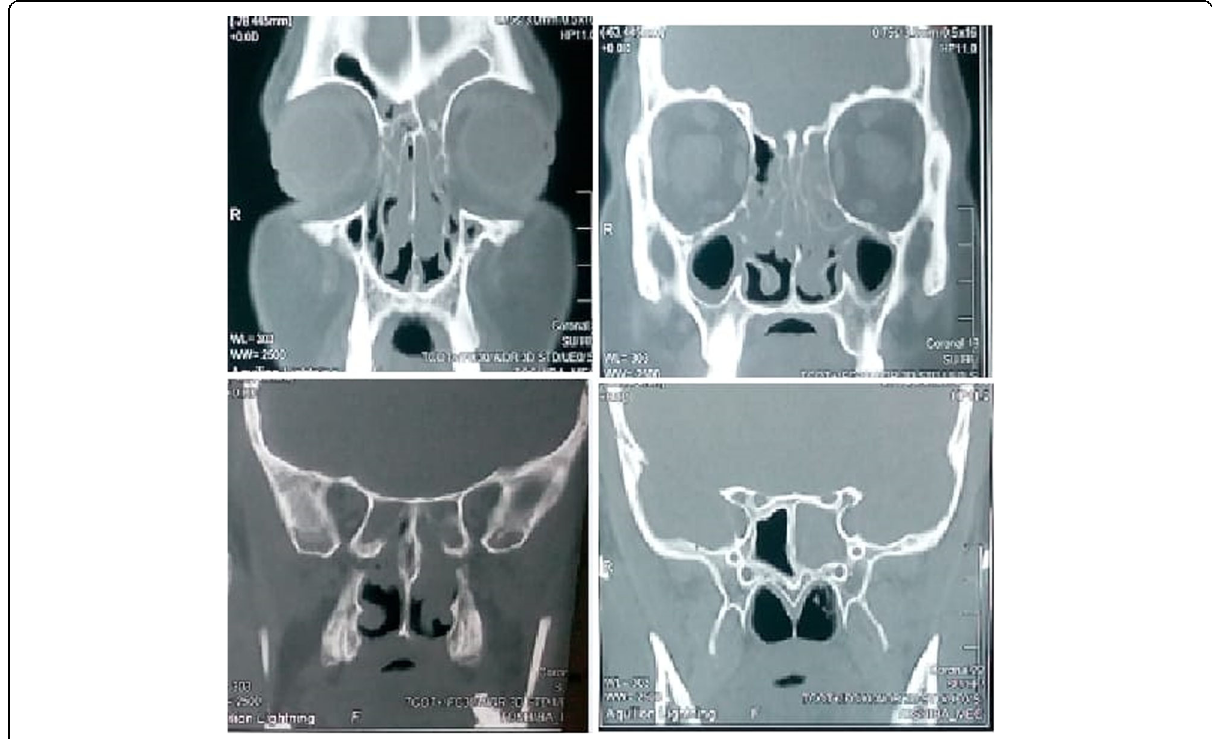
Fig. 9 CT PNS of case from injection group, before the treatment